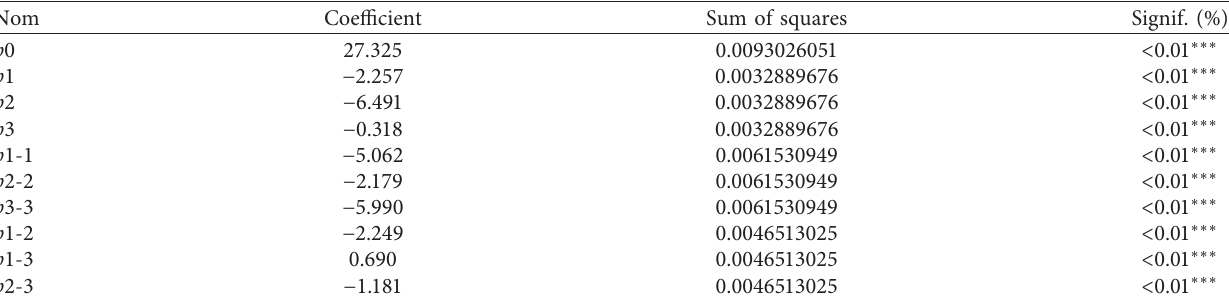
Table 6: Effect estimation, statistical significance, and regression coefficient estimates for phenolic compounds extraction from Z. mays